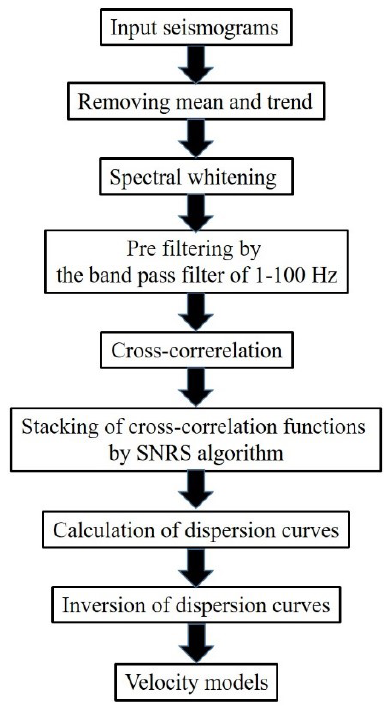
Figure 10. The workflow for data